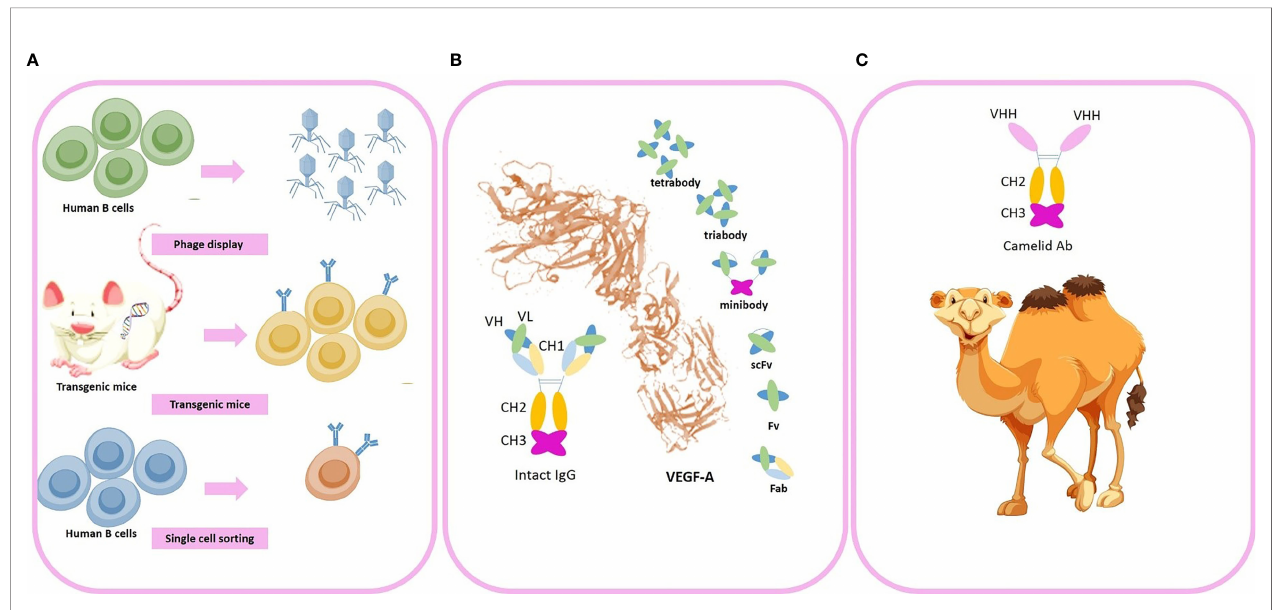
FIGURE 3 | Novel advances in generation of anti-angiogenic monoclonal antibodies (mAbs). (A) Novel strategies used for industrial production of engineered fully- humanized mAbs comprising (1) phage display technologies (2) transgenic mice (3) single-cell sorting. (B) An intact mAb and antibody fragments (i.e. minibody, tirabody, tetrabody, and scFv) (C) camelid antibodies. Some of the vectors used to design this fi gure were downloaded from Vecteezy under a free